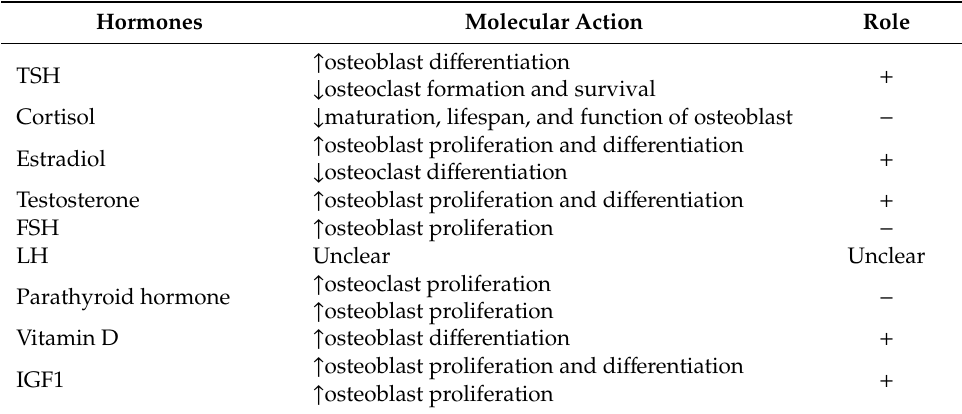
Table 1. The role of hormones on bone mass. Hormones Molecular Action